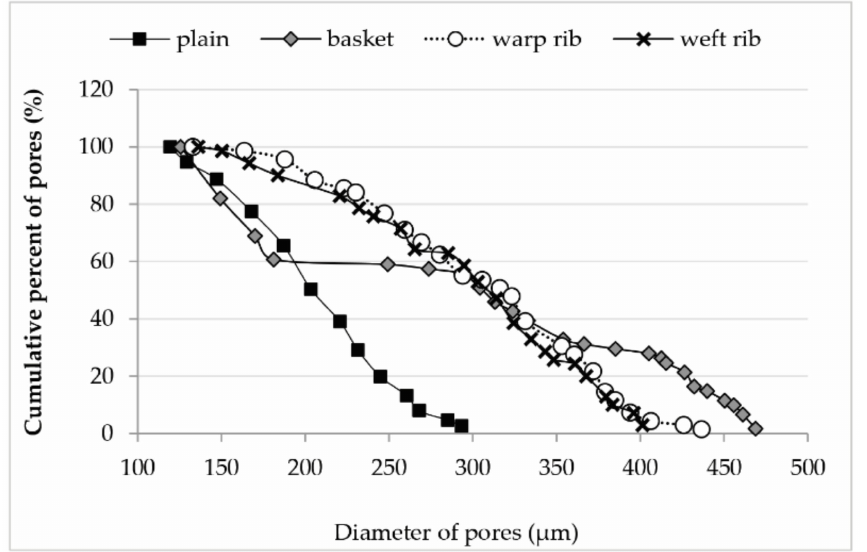
Figure 5. Cumulative percentage of pores in relation to the diameter of pores for all